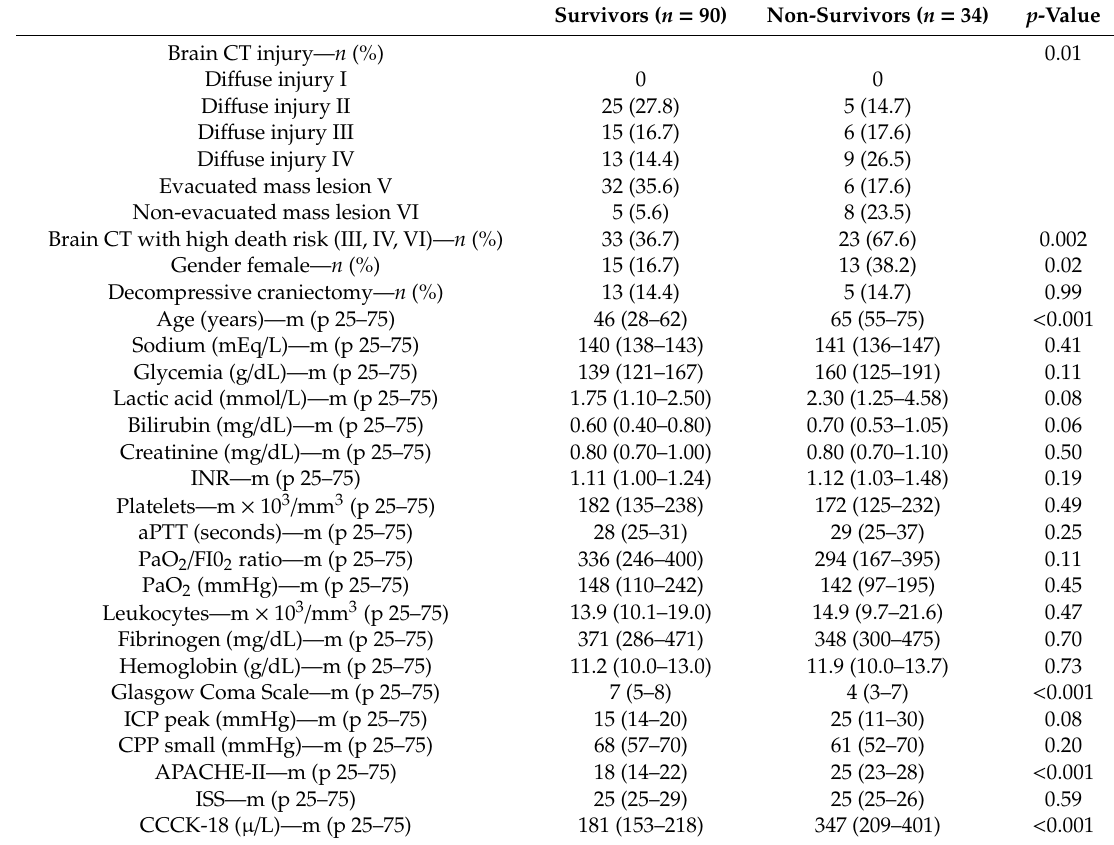
Table 1. Surviving and non-surviving patient characteristics on day 1 of trauma brain